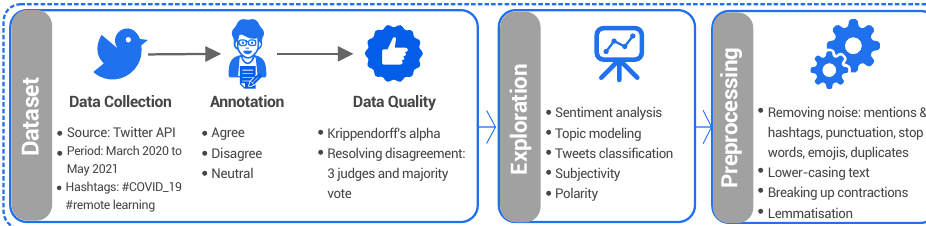
Figure 1. Main steps taken to create the StEduCov dataset.